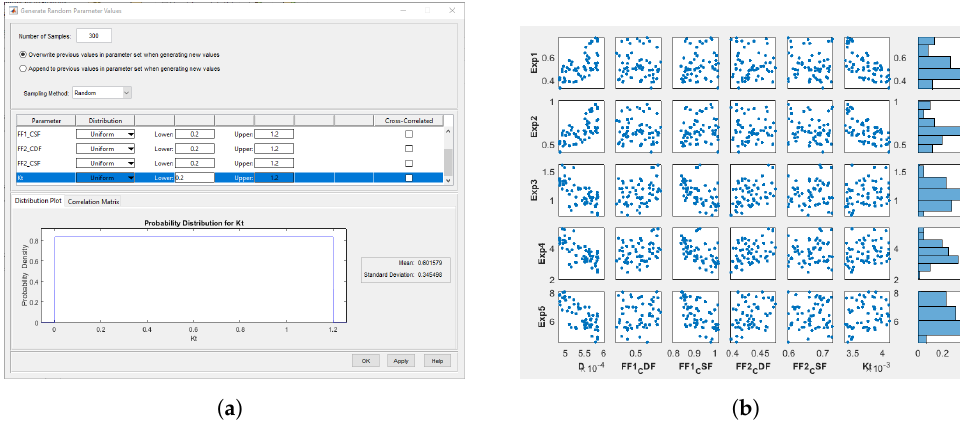
Figure 9. Sensitivity Analysis Tool. ( a ) Uniform random distribution generation. ( b ) Results of the exper- iment.